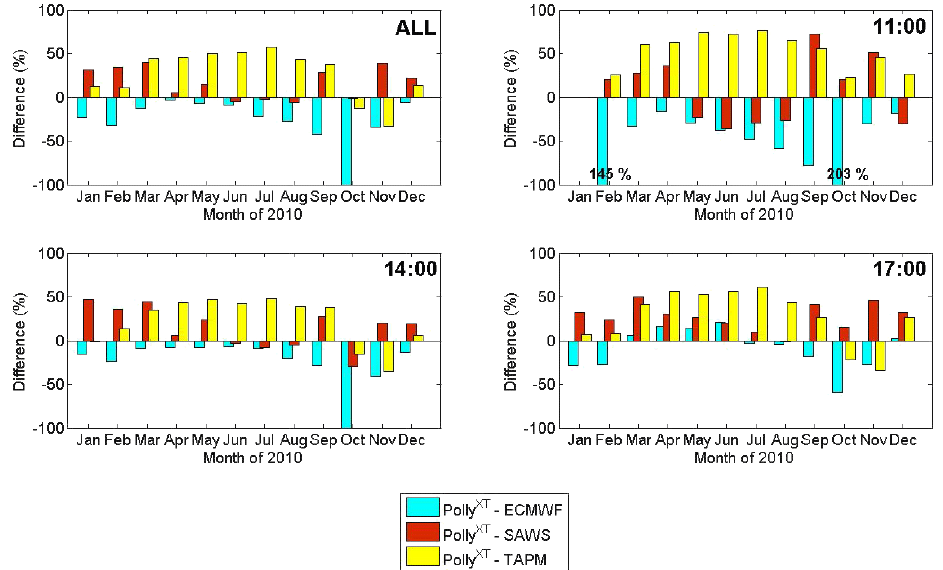
Fig. 7. Monthly mean differences in PBL height from the lidar and each model: (a) all values between 11:00–17:00, (b) 11:00, (c) 14:00 and (d) 17:00.